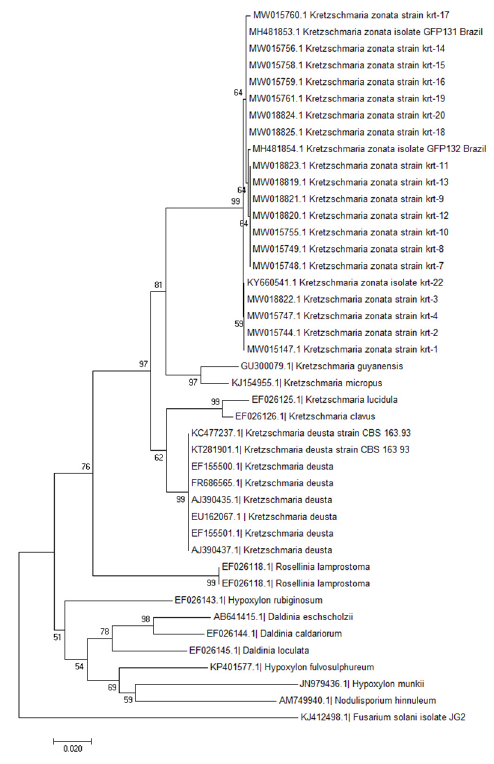
Figure 3. Neighbor-joining tree derived from 5.8-ITS of rDNA, showing the phylogenetic position of all K. zonata strains from this work. GenBank accession numbers are before the name of each strain. Bootstrap values were determined from 1000 iterations. Fusarium solani isolate JG2 was used as an out-group to root the tree.